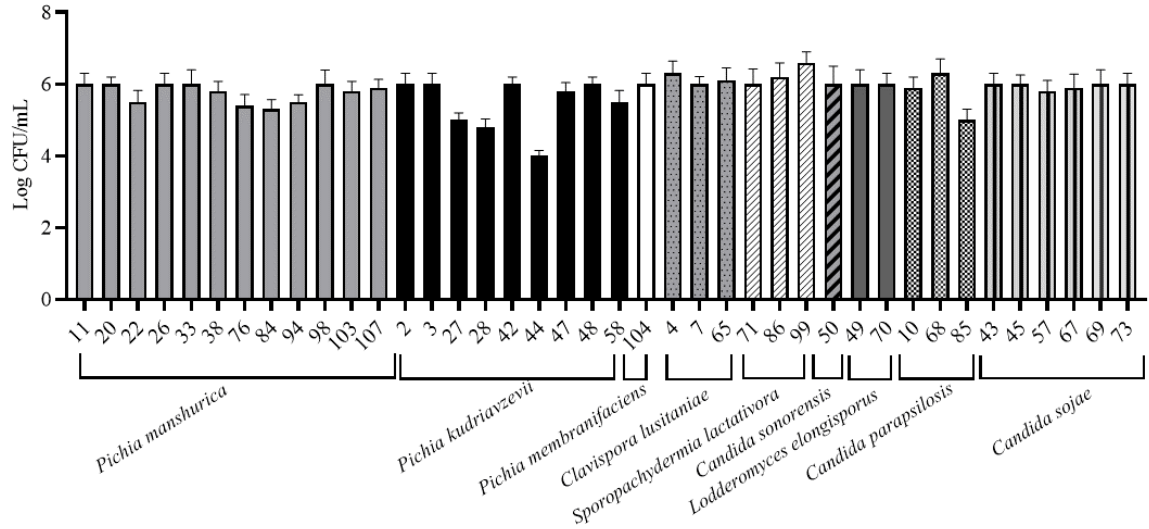
Figure 2. Viable yeast cell counts on steel surface.